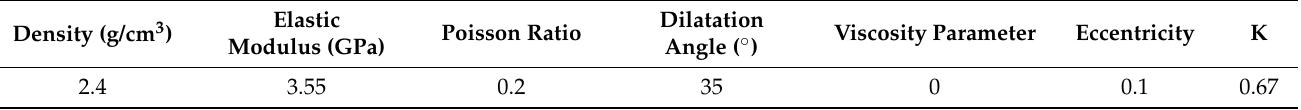
Table 2. Physical parameters of the studied tunnel lining.